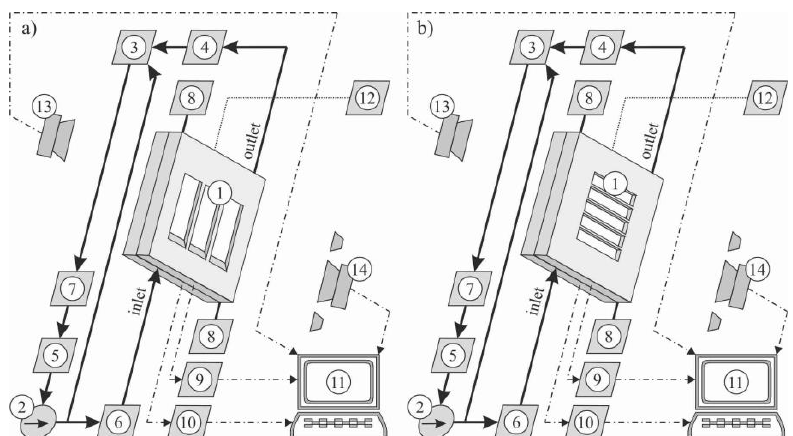
Figure 1. A schematic diagram of the experimental stand with a test section with three minichannels ( a ) and five minichannels ( b ); a test section (1), a gear pump (2), a compensating tank (3), a heat exchanger (4), a filter (5), a mass flow meter (6), a deaerator (7), a pressure meter (8), data acquisition stations (9,10), a PC (11), a power supply unit (12), an infrared camera (13), and a high-speed video camera (14).